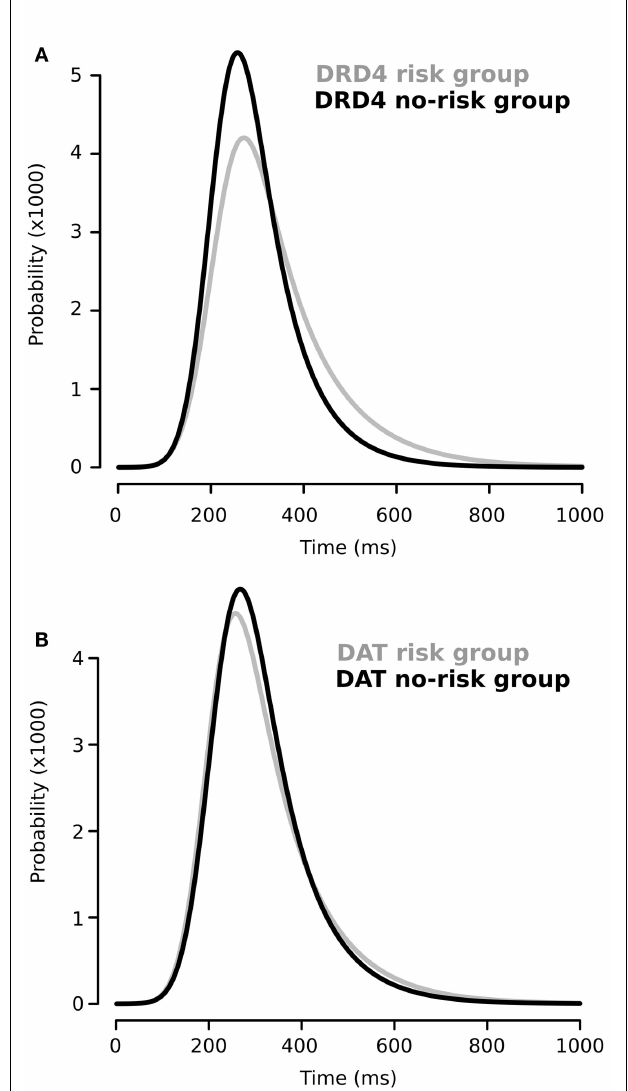
FIGURE 2 | Ex-Gaussian distributions for response times according to the presence/absence of previously described genetic risk variants for (A) DRD4 and (B) SCL6A3 / DAT1 . Black line: absence of risk alleles; gray line: presence of at least one risk allele (for a detailed description on group assignment criteria, please refer to Sections “Materials and Methods,” and Sections “Group